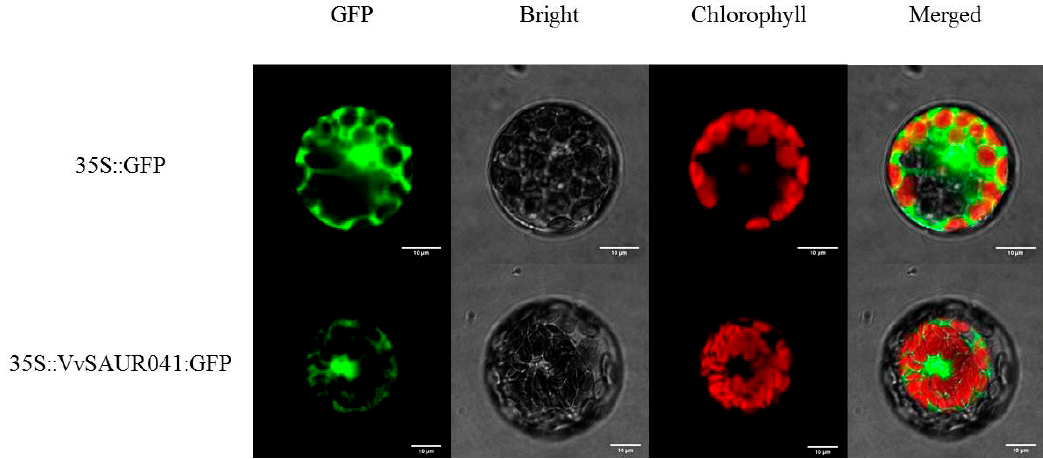
Figure 7. Subcellular localization of VvSAUR041. Vector control ( 35S::GFP ) and fusion protein construct 35S::VvSAUR041:GFP were introduced into Arabidopsis protoplast.